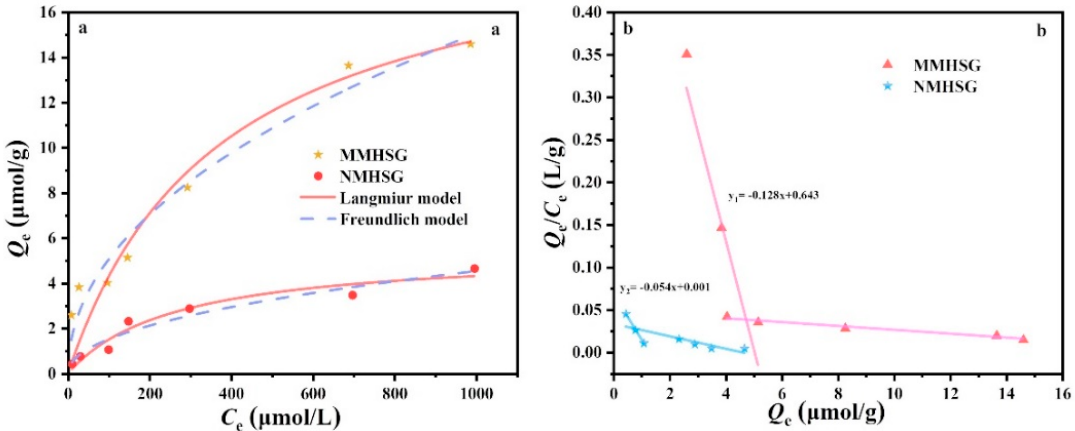
Figure 9. Non-linear Langmuir and Freundlich model fitting curves of MMHSG and NMHSG ( a ), and Scatchard analysis of the binding isotherms ( b ). Table 2. Adsorption equilibrium constants for Langmuir and Freundlich isotherm equations. Langmuir Isotherm Freundlich Isotherm Adsorbent